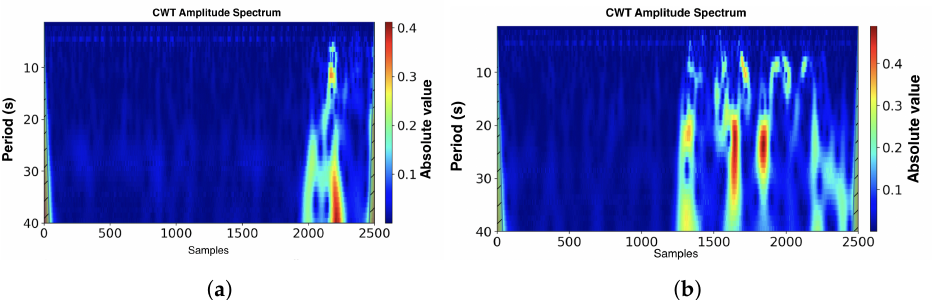
Figure 6. Scalograms of the bioradar signal. (The unit marks were added to the figure. This comment may be deleted.) ( a ) The fall event. ( b ) The squatting episode.